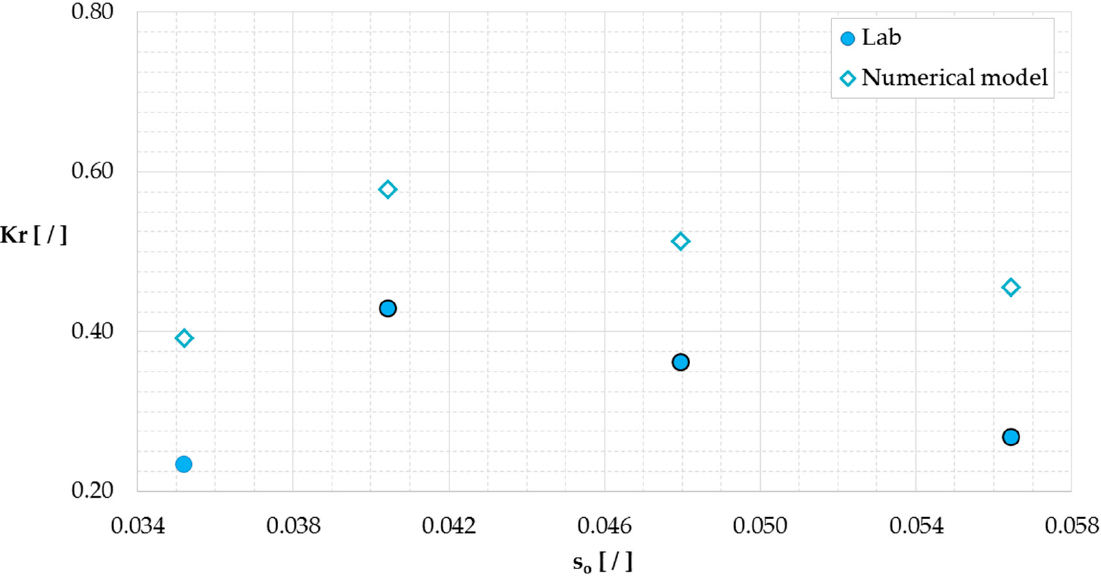
Figure 5. The laboratory vs. numerical model Kr for the normal wave conditions only.